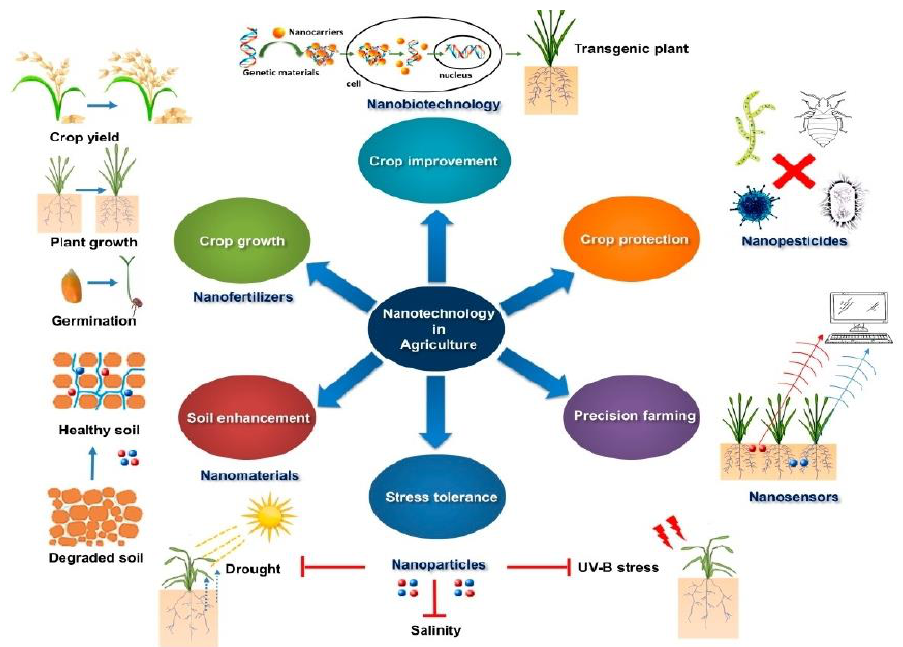
Figure 2. Various applications of nanotechnology in agriculture taken from [12]